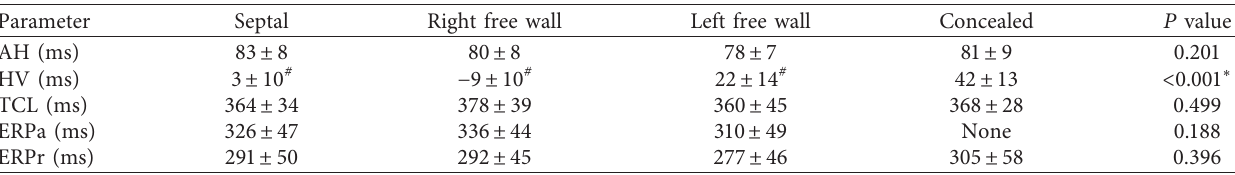
Figure 1: Pre- and postradiofrequency ablation findings for LVEF, SPWMD, and NT-proBNP in patients with septal and right free wall accessory pathways ( n � 40). Radiofrequency ablation of accessory pathways resulted in increased LVEF (a), recovery of SPWMD (b), and decreased NT-proBNP levels (c). Table 3: Electrophysiological